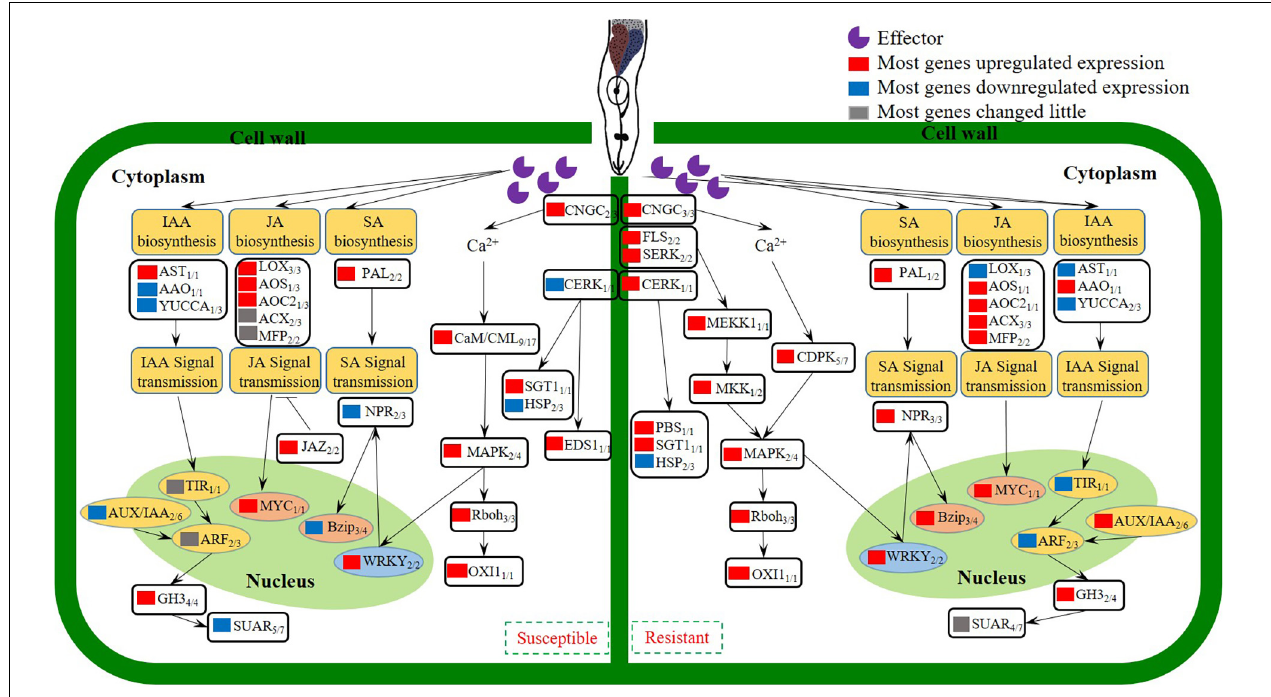
FIGURE 7 | Model depicting how the coordinated signaling network in cucumber leads to the induction of local and systemic defense against M. incognita